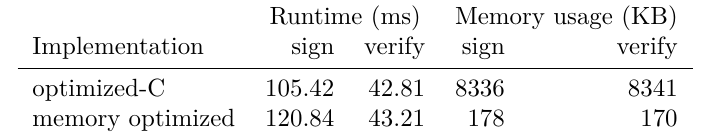
Table 12: Performance Impact of Memory Usage Tradeoffs for Picnic2-L1-FS